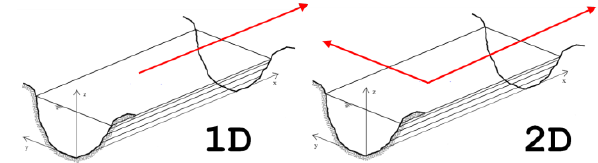
Figure 1. 1D and 2D models analyzing river